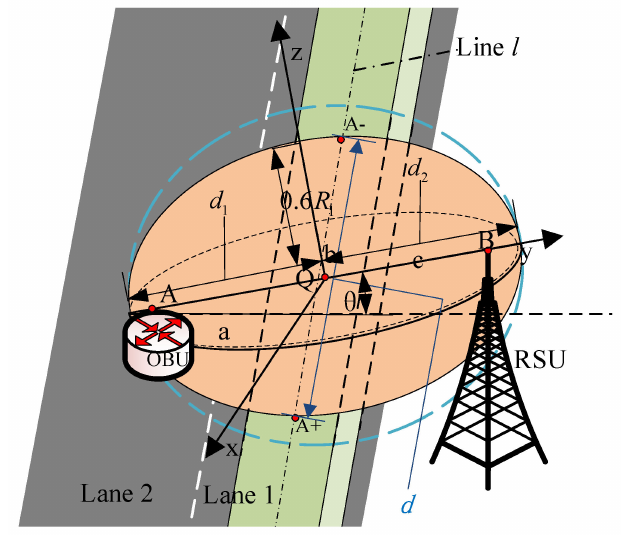
Figure 2. The illustration of the attenuation effect of a mobile truck on a communication link. The radius of the First Fresnel ellipsoid between A (the position of the top point of OBU when the line connecting the OBU and RSU is perpendicular to the middle line of the road) and B (the top point of RSU) is given by